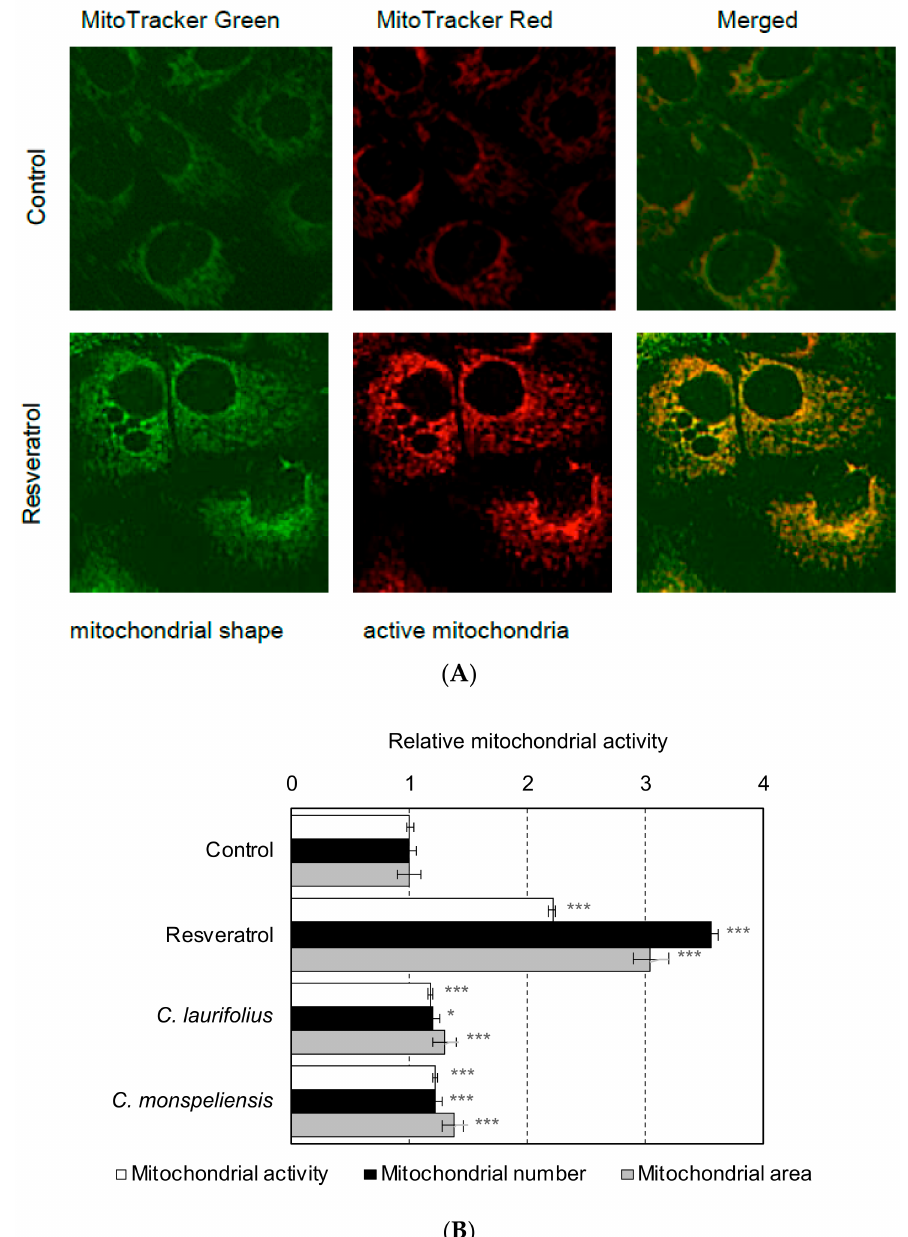
Figure 3. Effects of essential oils on mitochondria evaluated by fluorescence imaging. ( A ) Non-treated and resveratrol-treated HaCaT cells were stained with MitoTracker Red CMXRos and MitoTracker Green FM. ( B ) The effects of essential oils (final concentration: 100 ng/mL) on mitochondria were evaluated by using fluorescence probes of MitoTracker Red CMXRos and MitoTracker Green FM. The fluorescence intensity of MitoTracker Red CMXRos, corresponding to mitochondrial activity, and the number and area of mitochondria stained with MitoTracker Green FM were analyzed using IN Cell Analyzer 2200 (GE Healthcare) and IN Cell Investigator high-content image analysis software (GE Healthcare). Statistical significance was determined by using a two-sided Student’s t -test. Statistical significance was evaluated by comparison with the control of each experiment and defined as p < 0.05 (* p < 0.05; *** p < 0.001). Values are means ± SEM ( n = 3). As a control treatment, HaCaT cells were treated with